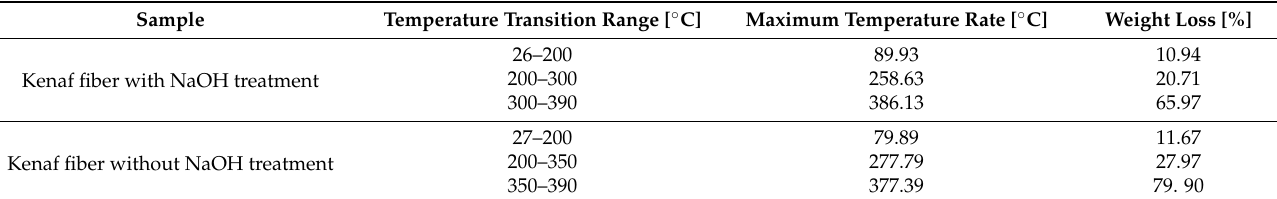
Table 2. Thermogravimetric (TG) results for kenaf fiber.